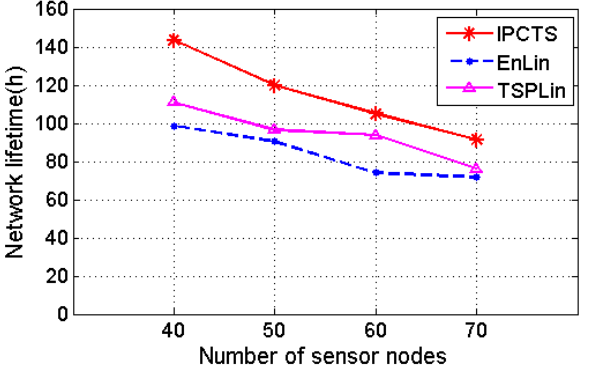
Figure 4. The effect of different charging paths on the network lifetime.